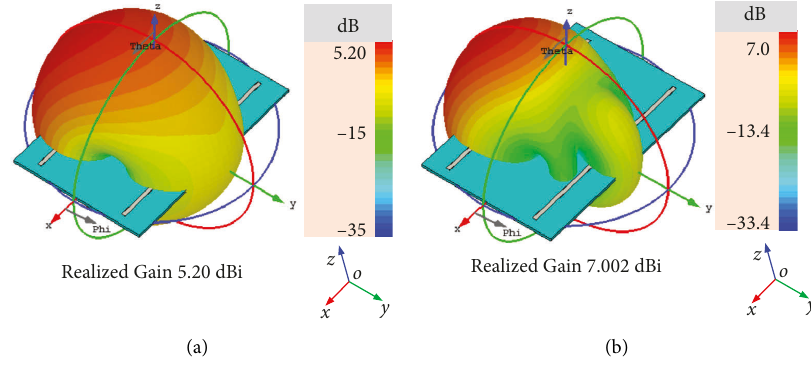
Figure 6: Simulated radiation patterns: (a) at 2.4GHz and (b) at